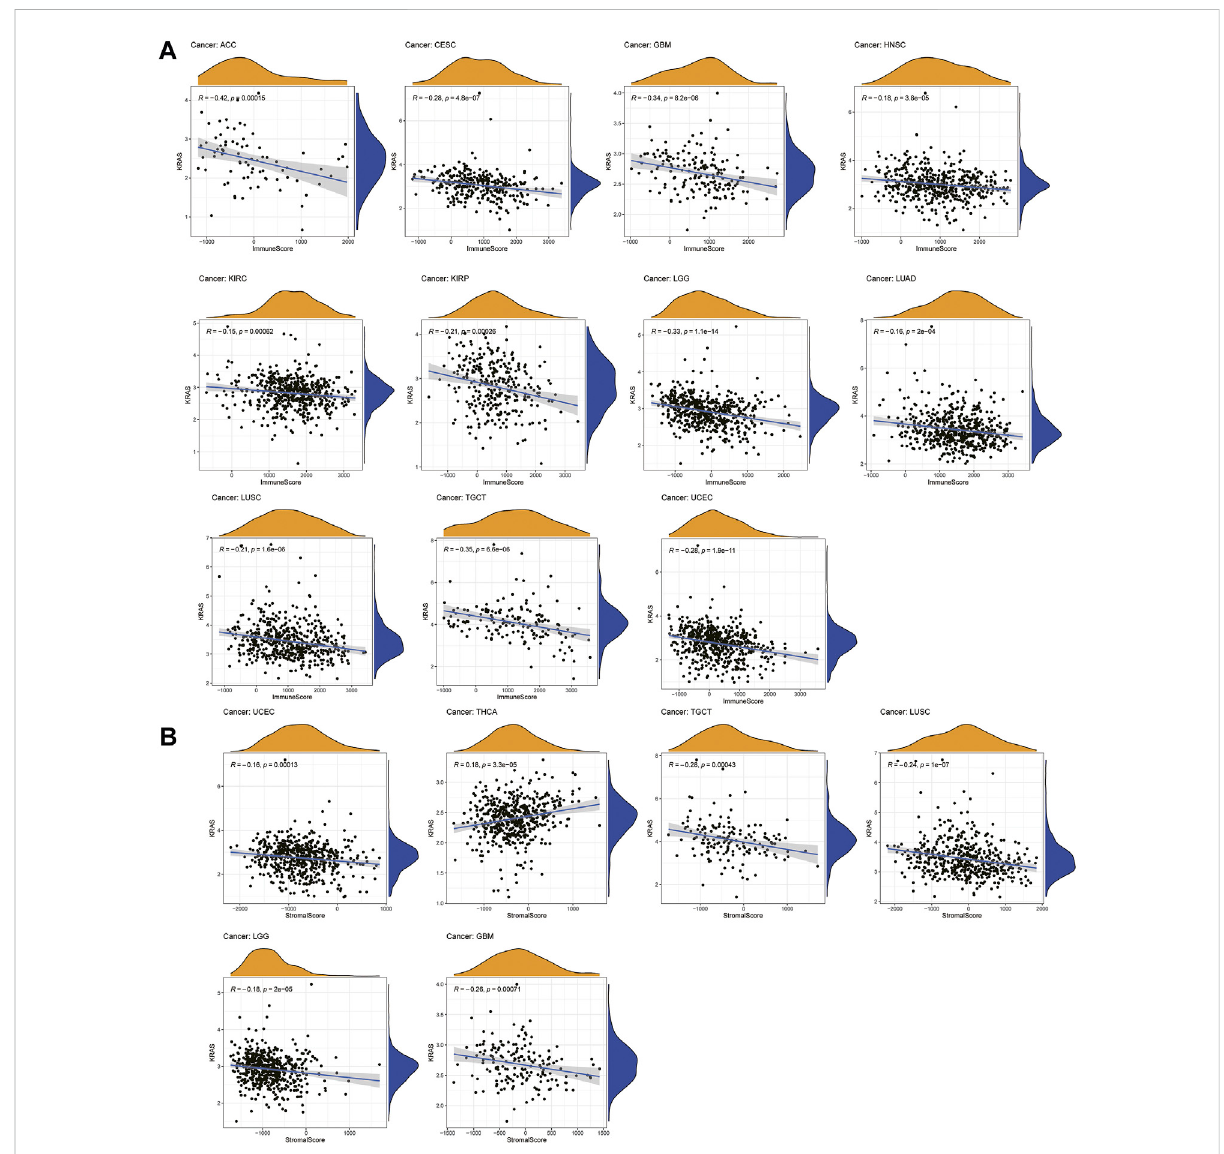
FIGURE 4 Relationships between KRAS expression and tumor microenvironment. (A) Immune score, (B) Stromal score.